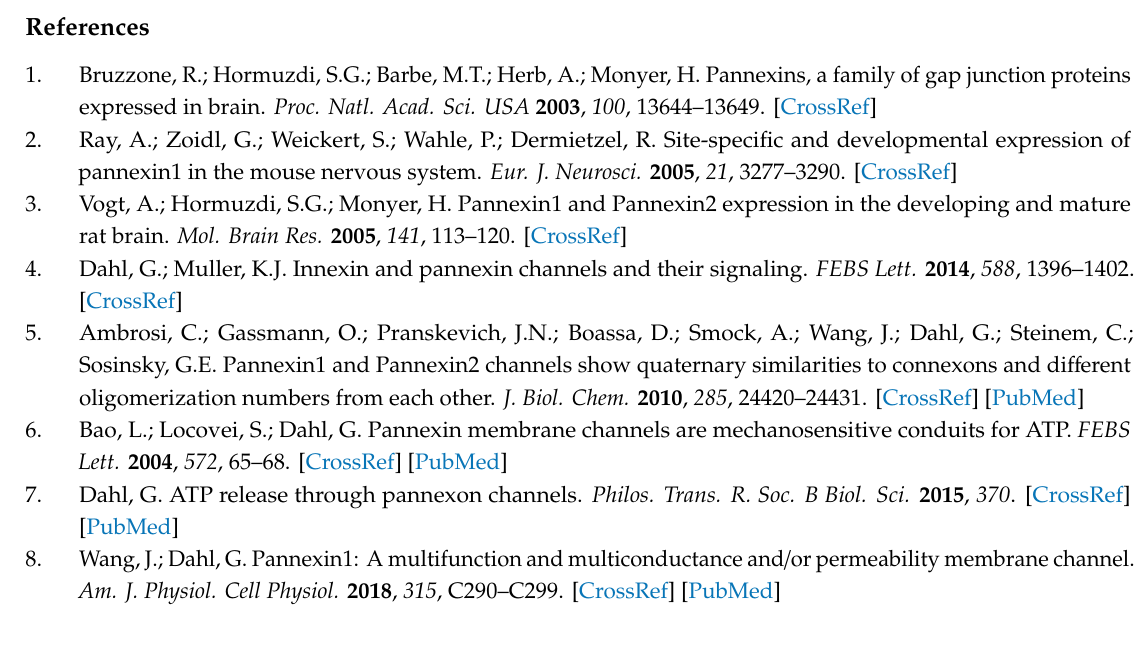
Figure S1: Topological comparison of panx1a with its ohnologue panx1b, human pannexin orthologs, and the C. elegans INX-6 protein. Figure S2: FRET distance graph shows the FRET distance using the reference distance between DsRed and EYFP pair